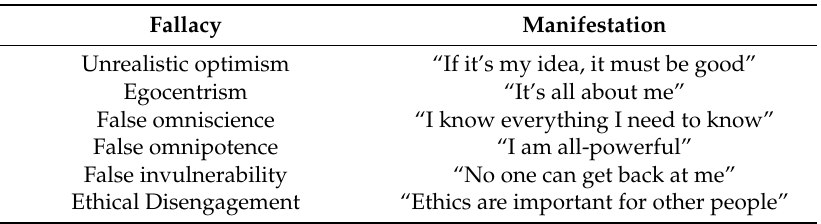
Table 3. Kinds of